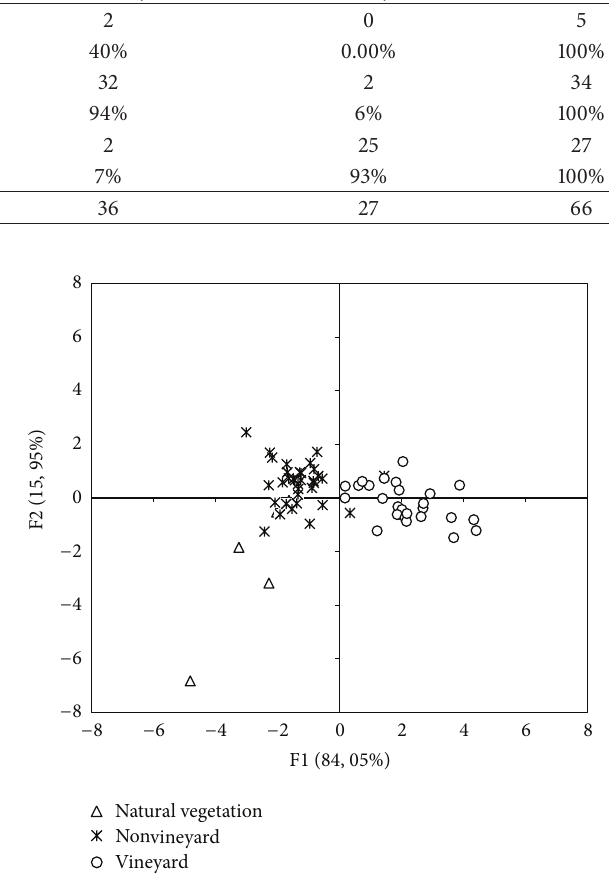
Figure 2: Factors of discriminant analysis showing land use groups formed according to Cu and Zn concentrations in soil. Table 5: Factor loadings generated by discriminant